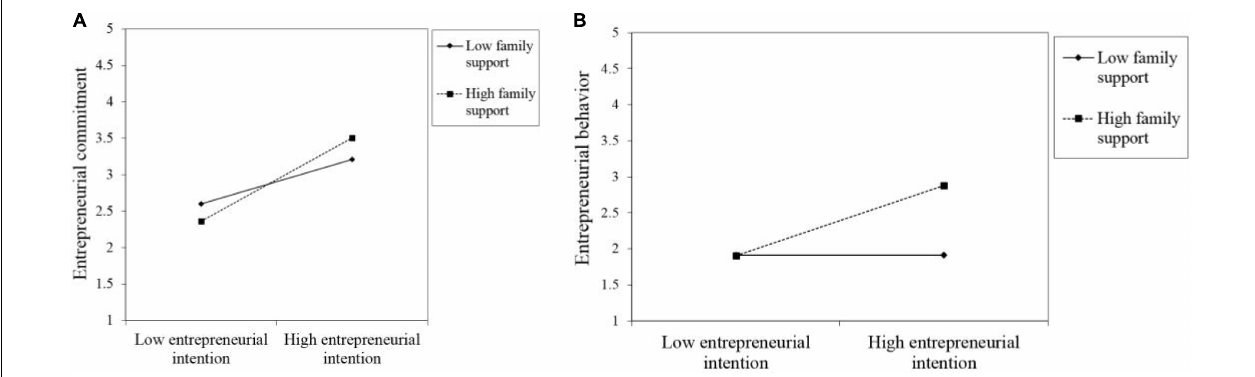
FIGURE 2 | The moderation effect of family support. (A) family support moderated the relationship between entrepreneurial intention and entrepreneurial commitment. (B) family support moderated the relationship between entrepreneurial intention and entrepreneurial